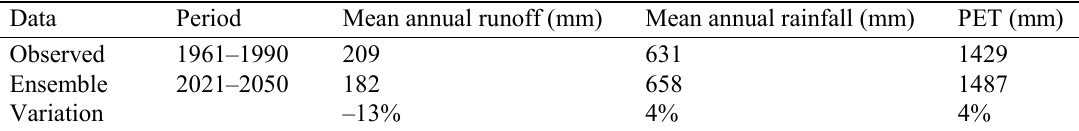
Table 2 Contrast of mean annual runoff, rainfall and PET for Fuensanta